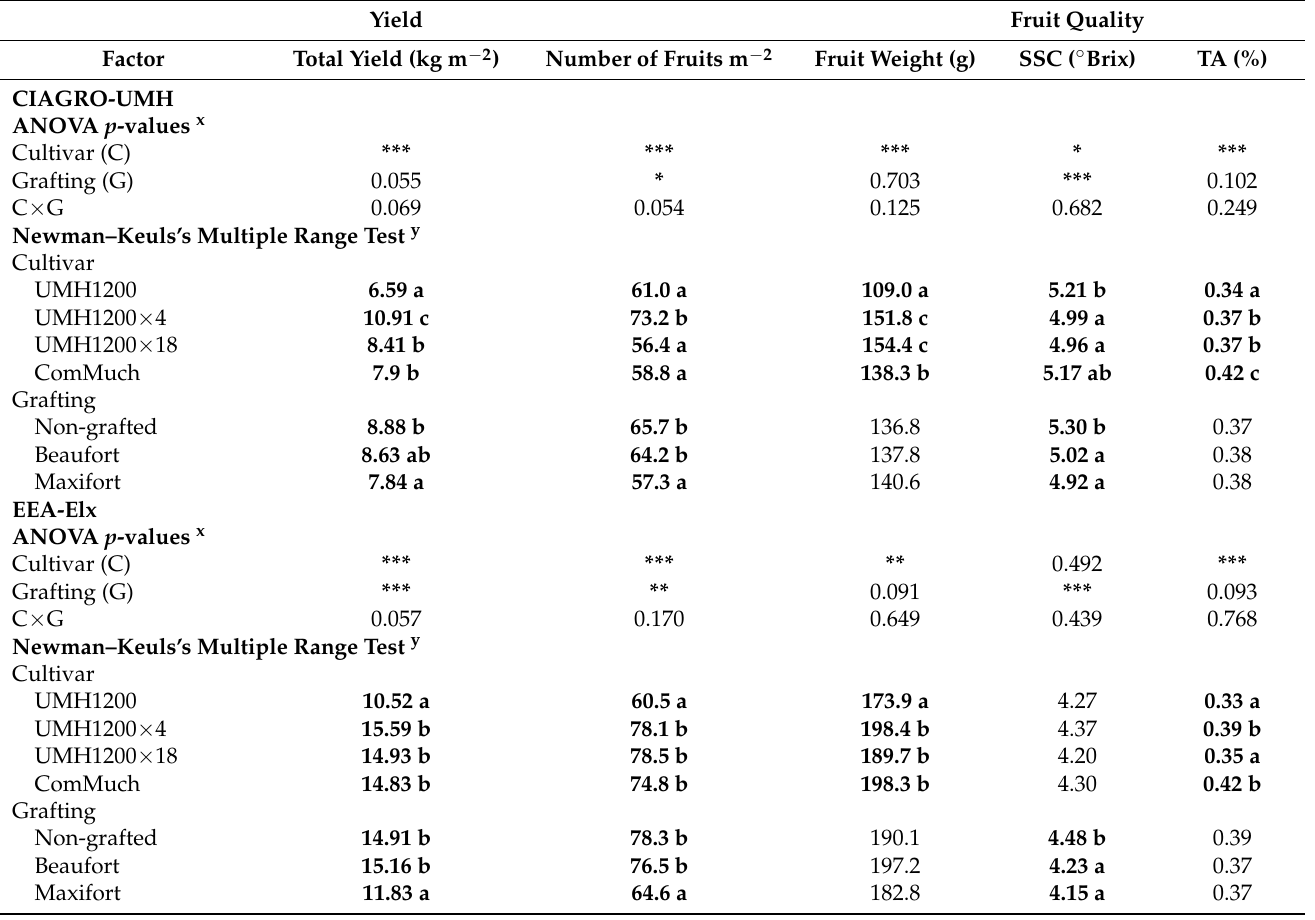
Table 2. Effect of cultivar and grafting ( p -values from ANOVAs and Newman–Keuls’s multiple range test) in agronomic and basic quality traits (SSC and TA) evaluated at CIAGRO-UMH and EEA-Elx. ComMuch: Commercial Muchamiel. Bold format indicates statistical